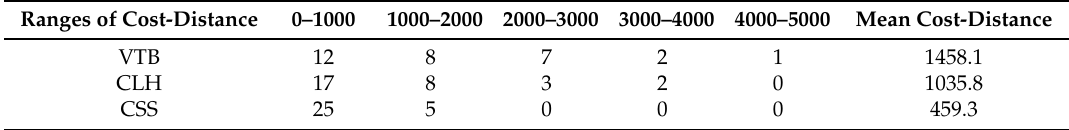
Table 1. The distribution of cost-distance (m) for sampling plots in different ranges. VTB, CLH and CSS refer to Vegetation Type Based, traditional Conditioned Latin Hypercube and Cost-constrained sampling strategies,